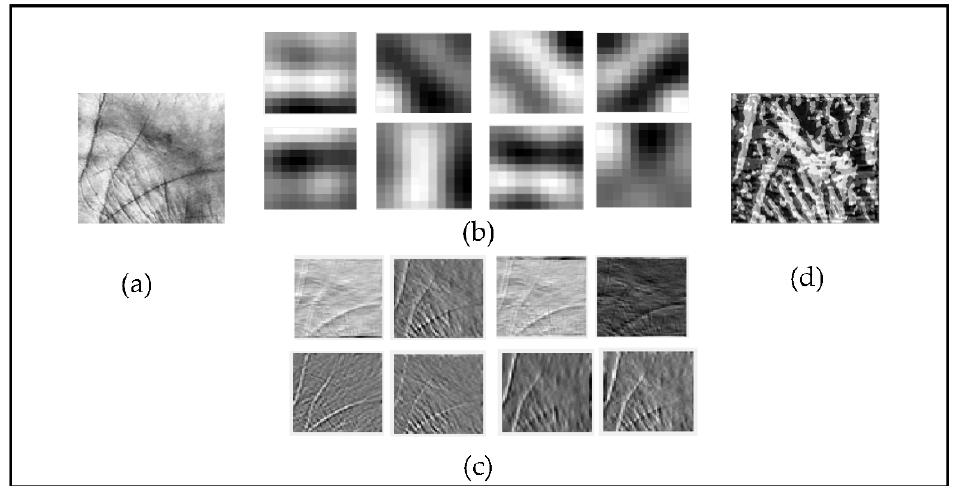
Figure 2. ( a ) Palmprint image, ( b ) pre-learned filter with a size of l × l = 11 × 11 and bit string length of n = 8, ( c ) BSIF features, and ( d ) final BSIF encoded features.